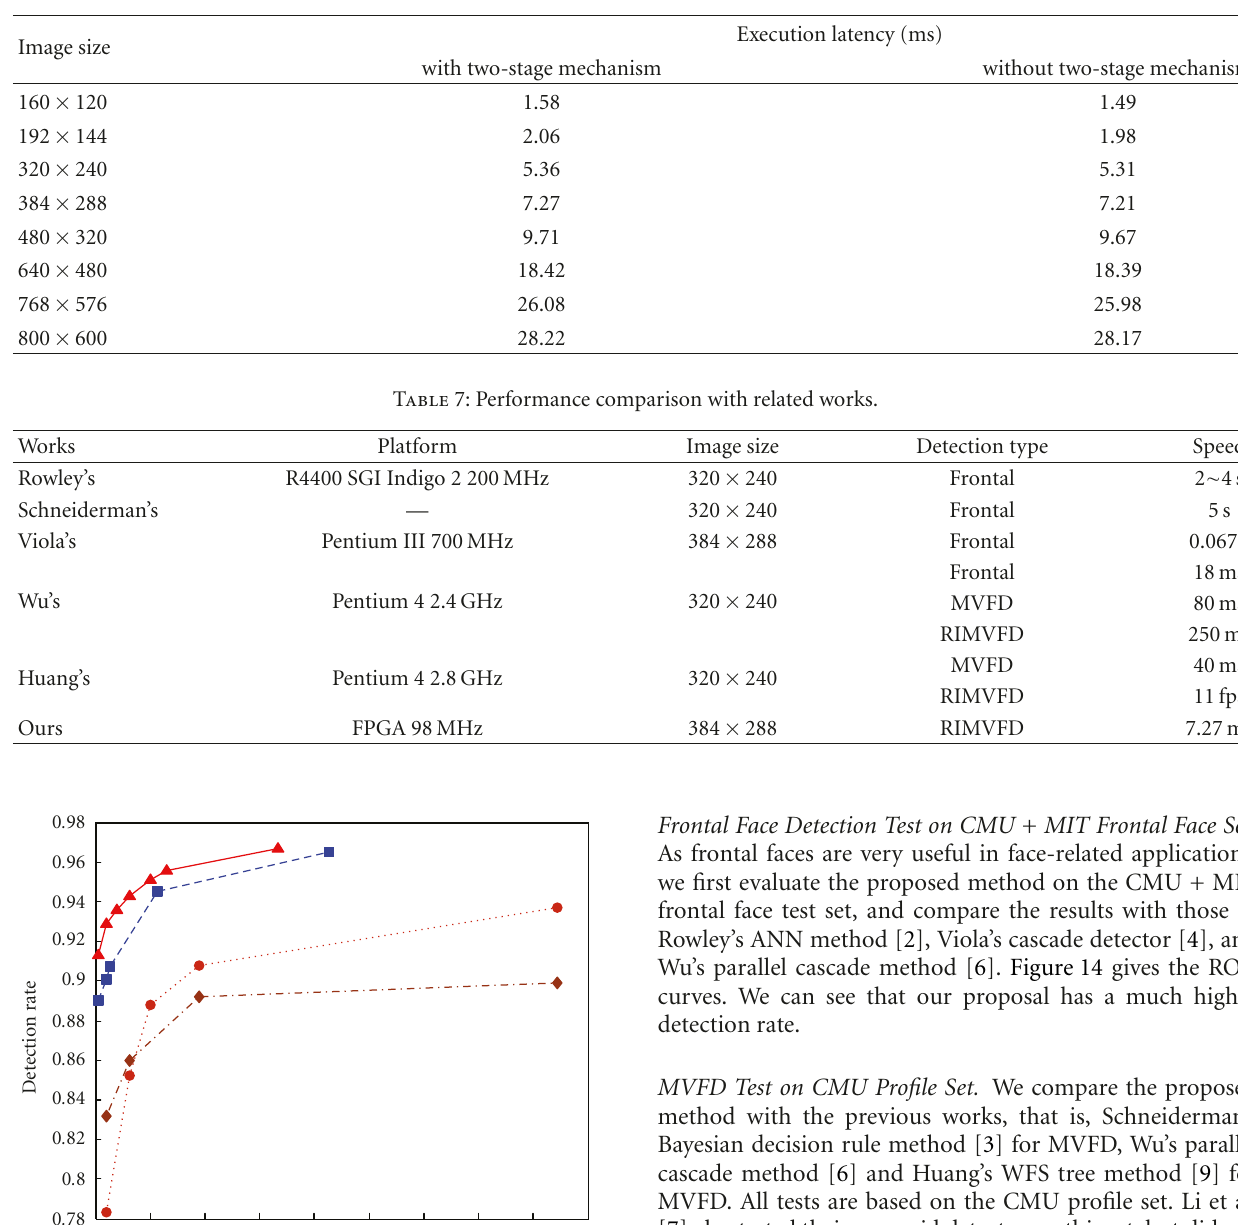
Table 6: Performance comparison for FPGA design with and without two-stage mechanism.